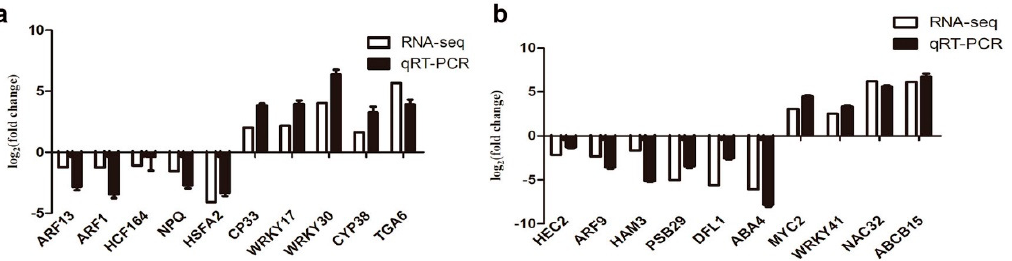
Figure 13. Validation of RNA-seq by qRT-PCR. ( a ) qRT-PCR analysis of DEGs in comparison groups of CK vs. H1, ( b ) qRT-PCR analysis of DEGs in comparison groups of CK vs. H3. CK, control group; H1, group with heat stress treatment for 1 d; H3, group with heat stress treatment for 3 d.